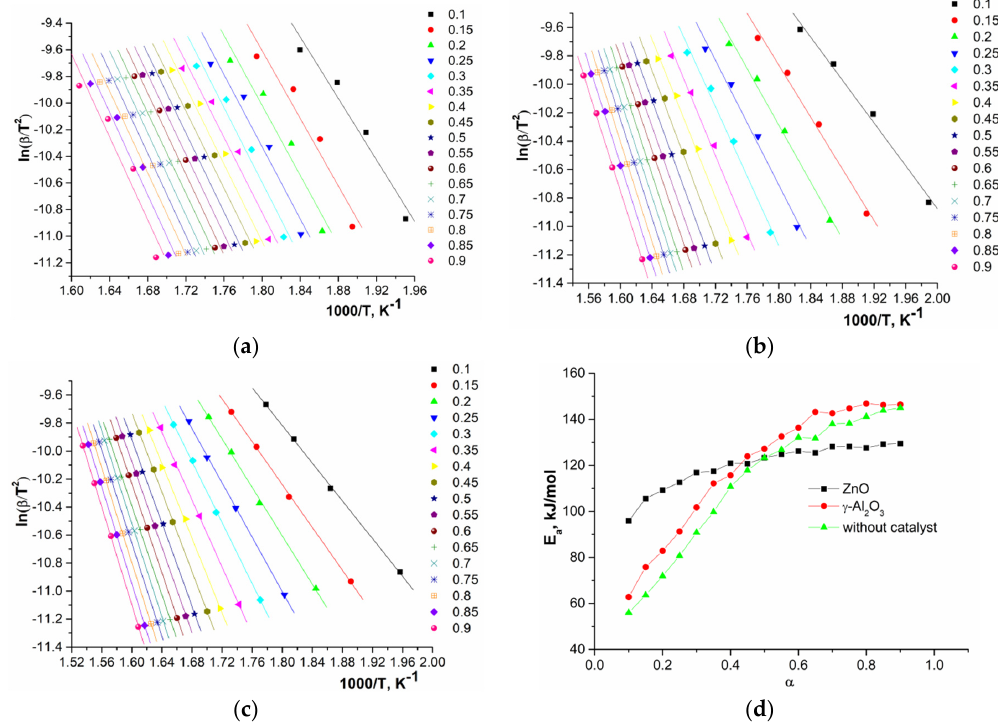
Figure 8. Dependences of ln( β / T 2 ) on 1000/ Т for depolymerization in the presence of ZnO ( a ), γ -Al 2 O 3 ( b ), without catalyst ( c ), and of activation energy on conversion ( d ) calculated by CR method.